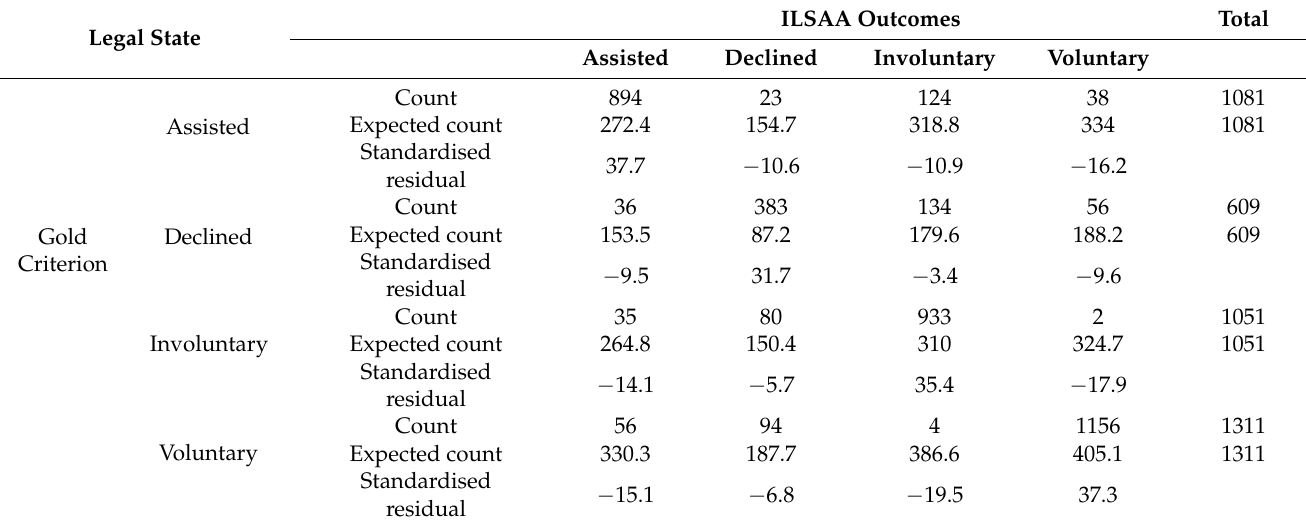
Table 2. Standardised residuals comparing the legal states yielded by the ILSAA outcomes to the gold standard legal states.